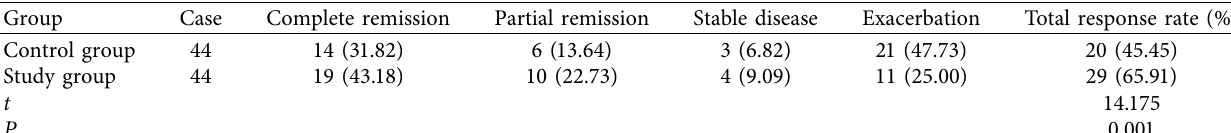
Table 1: The clinical response rates of AML patients following intravenous administration of cytarabine supplemented with either idarubicin or daunorubicin.